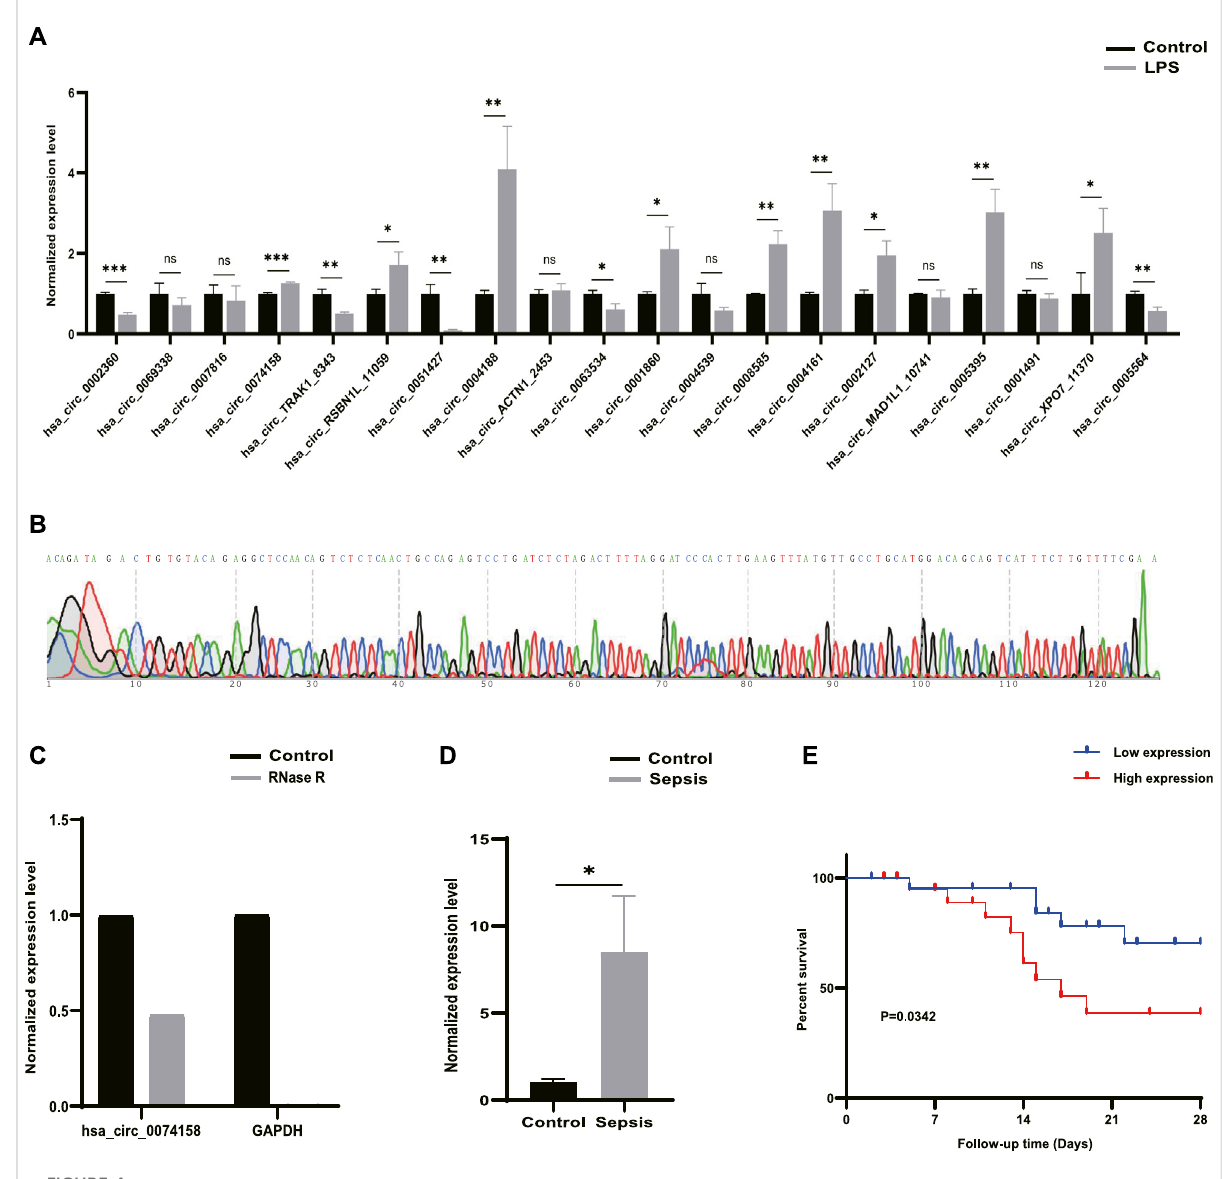
FIGURE 4 Candidate circRNAs. (A) Validation of20DEcircRNAsexpressionbyRT-qPCR. (B) Sangersequencingcon fi rmedthebacksplicejunctionsiteof hsa_circ_0074158.GreenstandsforA,redstandsforT,blackstandsforG,andbluestandsforC. (C) RNaseRtreatmentexperiments. (D) Validationof thehsa_circ_0074158expressioninthewholebloodof44patientswithsepsis and48healthyindividuals. (E) Kaplan-Meiersurvivalcurveofpatients with sepsis. * p < 0.05, ** p < 0.01, *** p < 0.001. Control: Control groups. LPS: LPS groups. RNase R: RNase R treatment groups. Sepsis: Sepsis